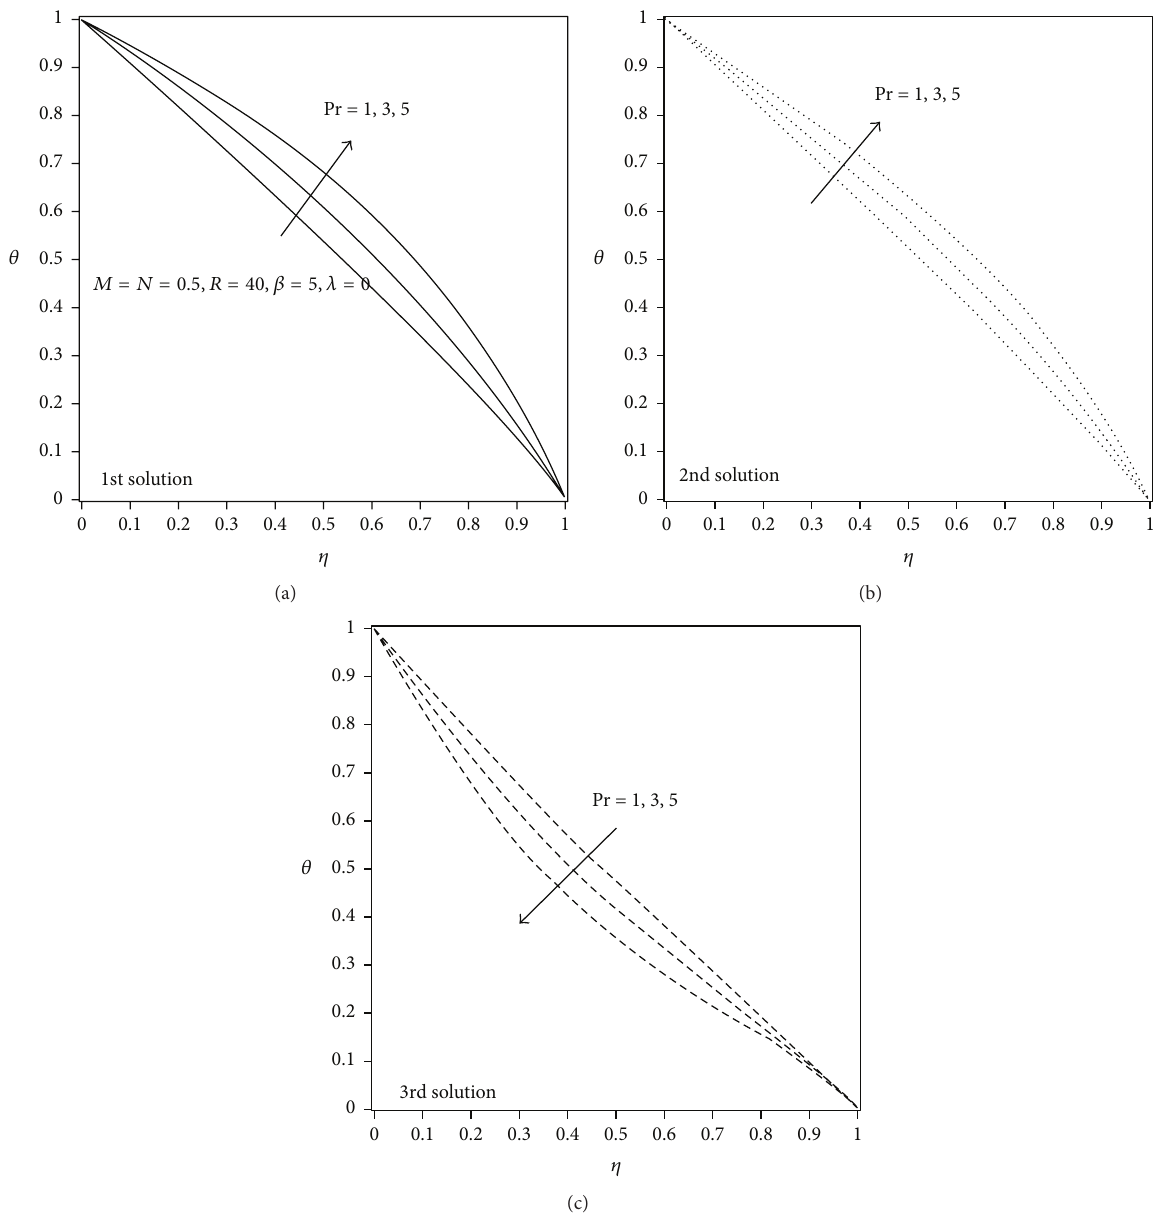
Figure 5: Effect of Prandtl number Pr on temperature profile 𝜃(𝜂) .